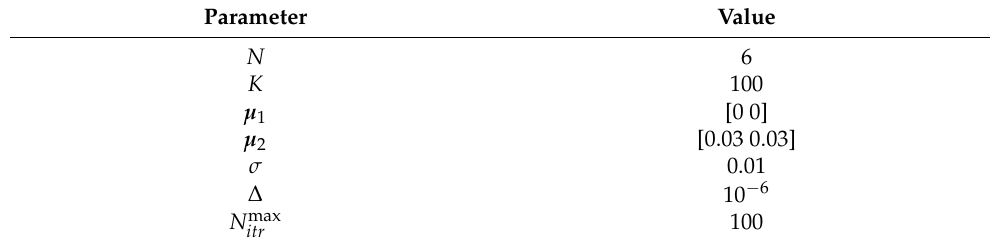
Table 2. Simulation parameters.